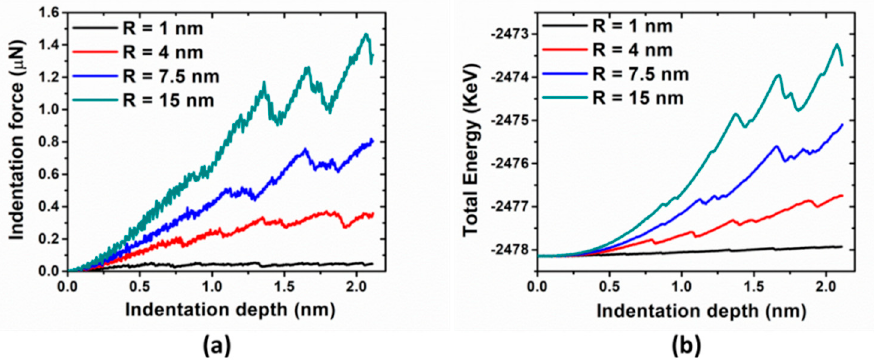
Figure 2. ( a ) Indentation force and ( b ) total energy vs. indentation depth for perfect crystal, indented with different tip